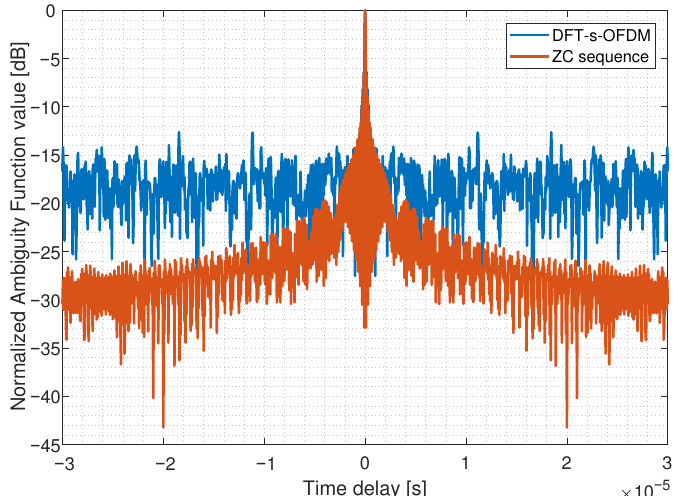
Figure 15. Comparison of ambiguity functions between DFT-s-OFDM and ZC.